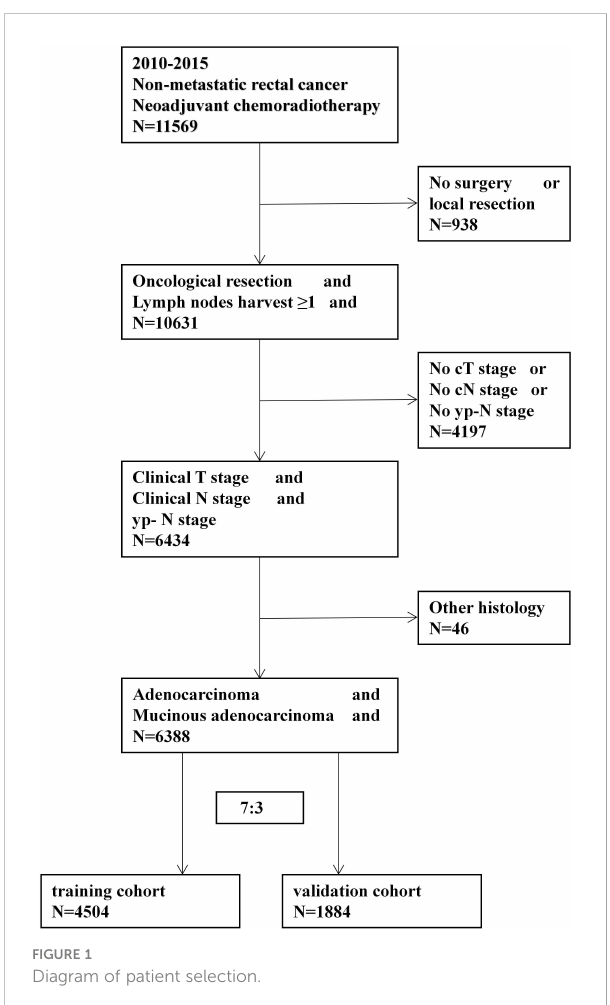
FIGURE 1 Diagram of patient